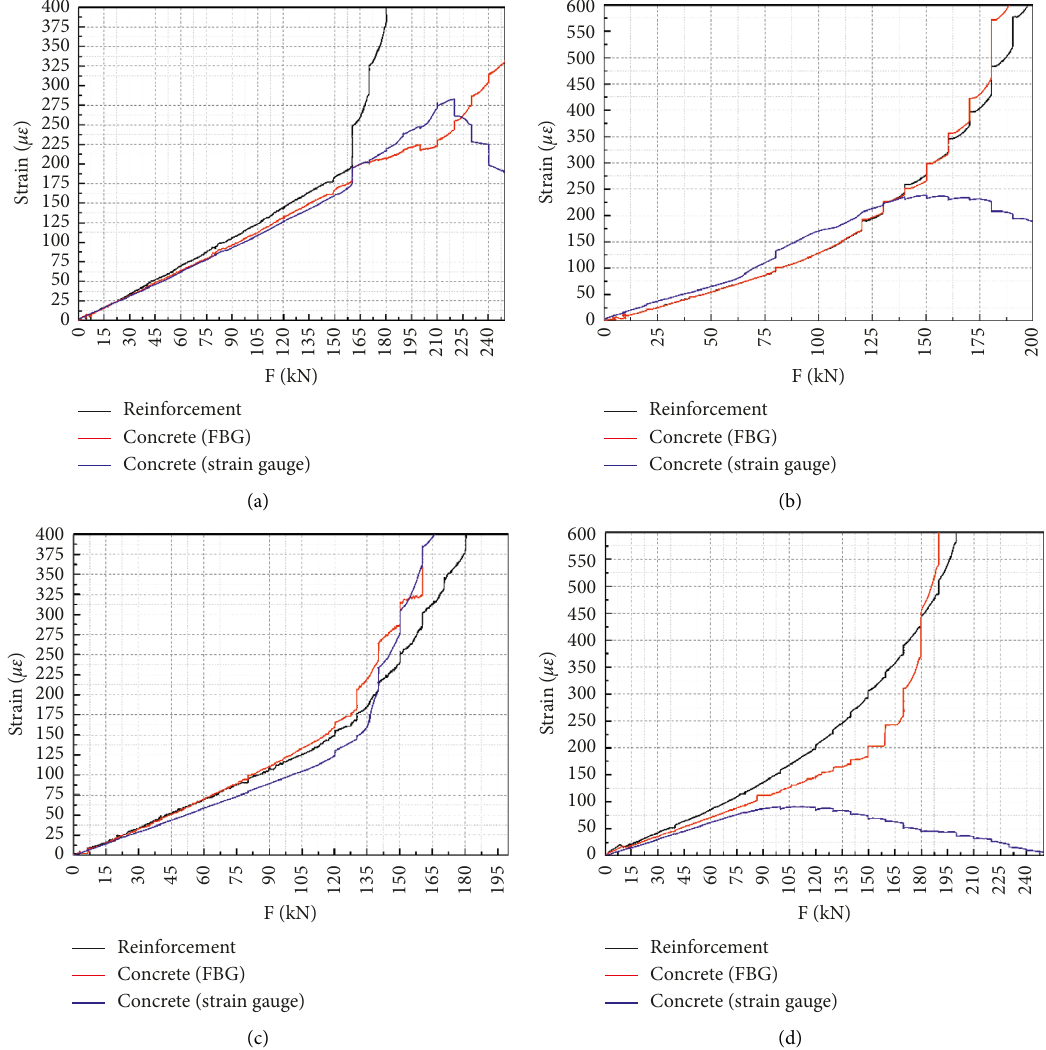
Figure 15: Strain of steel bars and concrete of specimens. (a) 0P10, (b) 10P10, (c) 10H10, and (d)